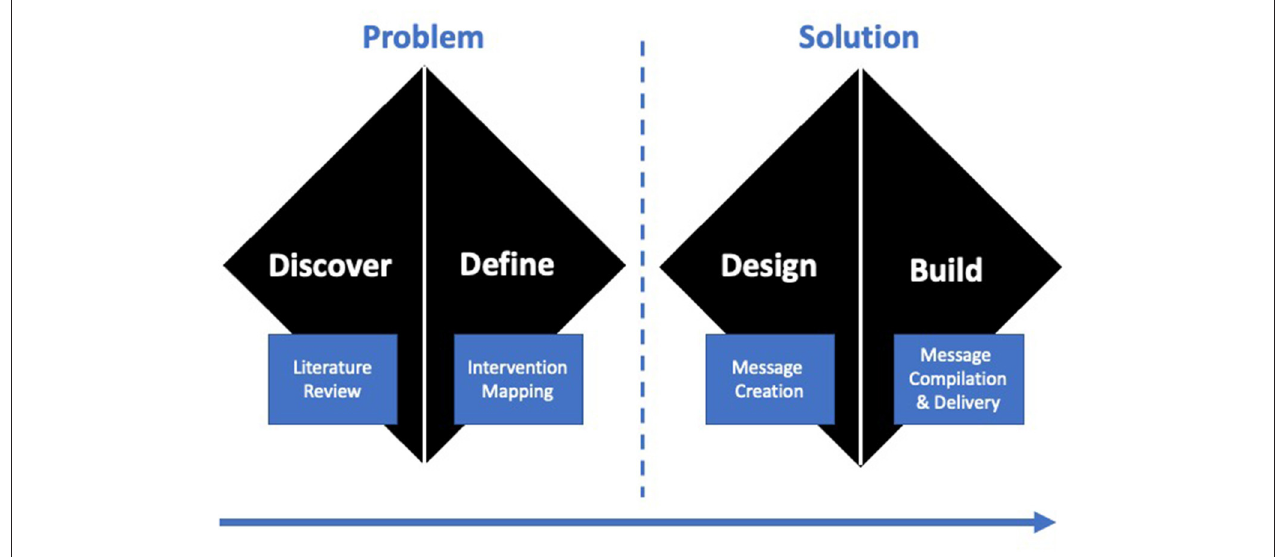
FIGURE 1 | Consistent with the UK Design Council’s Double Diamond model (i.e., discover-define-develop-deliver), behavioral science can be interwoven into the model’s best practice methods that alternate between divergent stages, where the focus is on gathering information and thinking broadly, and convergent stages, where the focus is on prioritization and